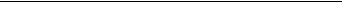
:R :R = (cid:27) (1) (cid:27) (2) (cid:27) (3)